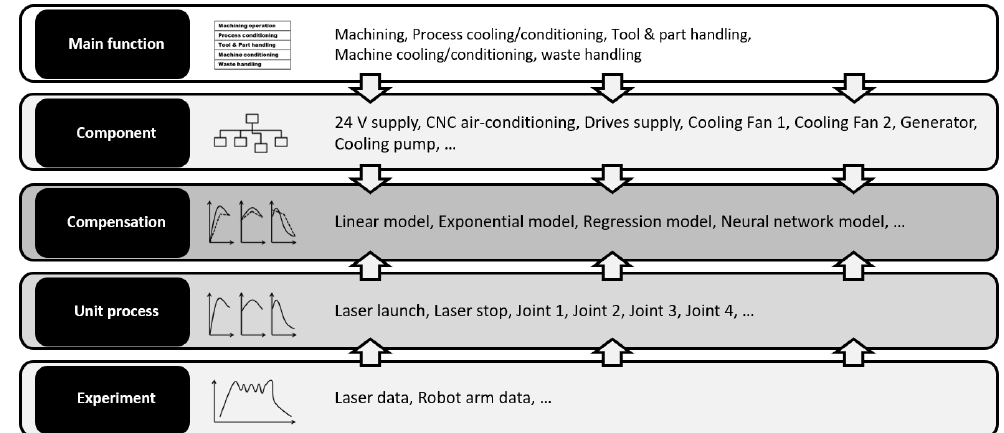
Figure 3. Compensation between the functional approach and the process